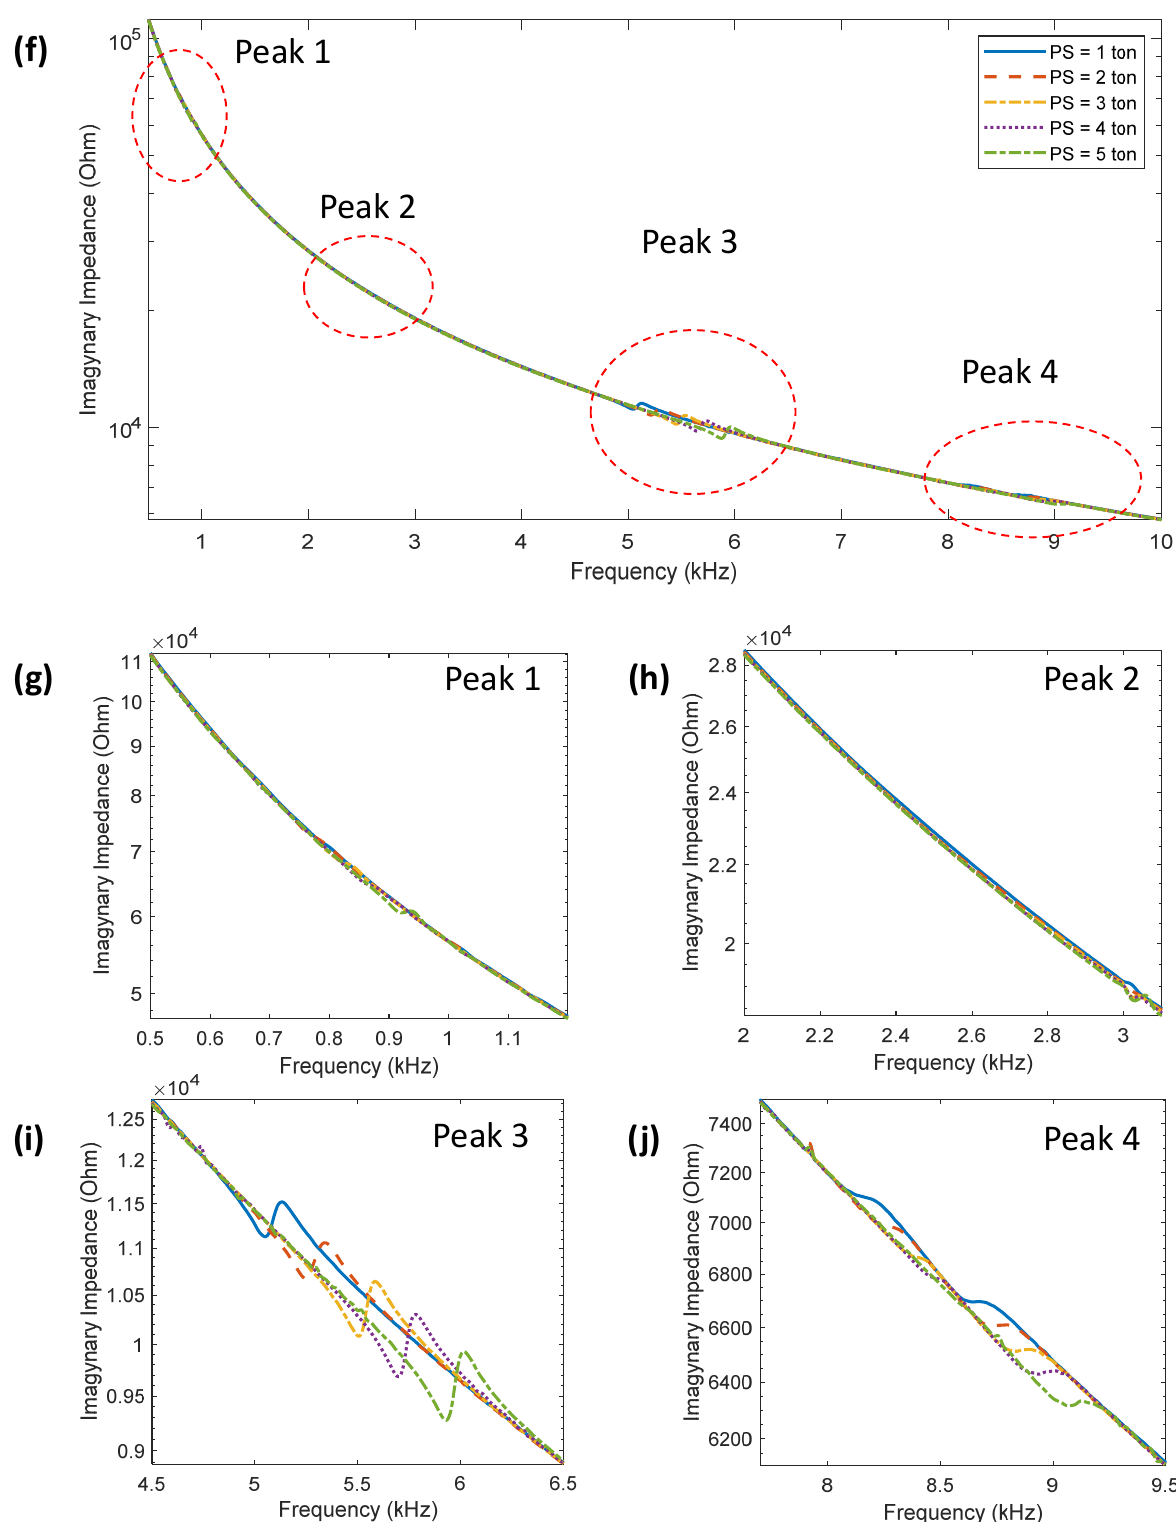
Figure 7. Resonant EMI responses of the smart strand ( a )–( e ) Real part; ( f )–( j ): Imaginary part. The imaginary part of the EMI response corresponding to five PS levels is depicted in Figure 7f. This also showed variations under the effect of the PS force. However, the variations were different for each impedance peak. Specifically, the imaginary parts of Peak 1 and Peak 2 showed ignorable changes while the remainder had